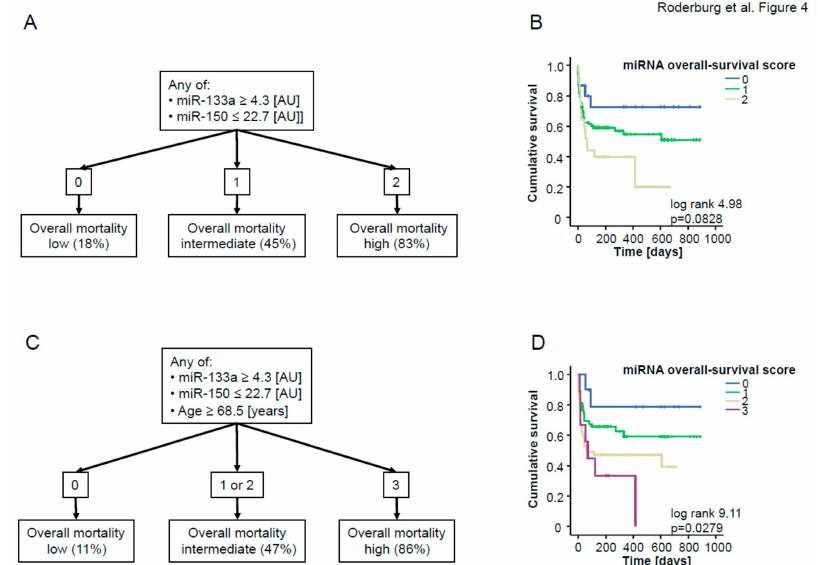
Figure 4. ( A ) The individual “overall survival score” was calculated as described in the text. In brief, patients with higher (in case of miR-133a) or lower (in case of miR-150) levels than the respective cut-o ff were given one point for each individual dysregulated miRNA. All points were added to an “overall survival score”, ( B ) Kaplan–Meier curve analysis of ICU patients demonstrates that patients with higher “overall survival scores” had an increased overall mortality compared to other patients; p -values are given in the figure. ( C ) Age was included into the score. Patients older than 68.5 years received one additional point. ( D ) Kaplan–Meier curve analysis of ICU patients demonstrates that patients with higher scores had an increased overall mortality compared to other patients; p -values are given in the